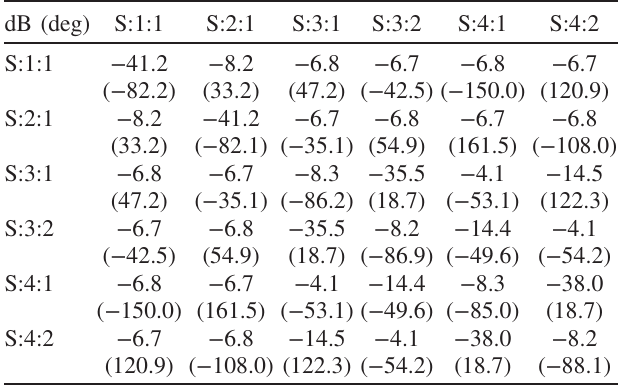
TABLE I. Simulated scattering matrix of the expanded